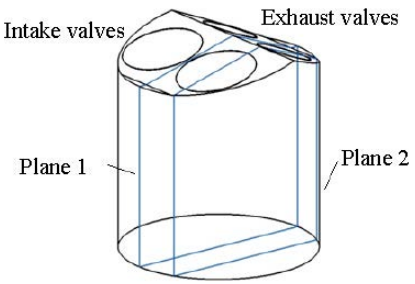
Figure 5. Optical measurement planes for investigating tumble flow.